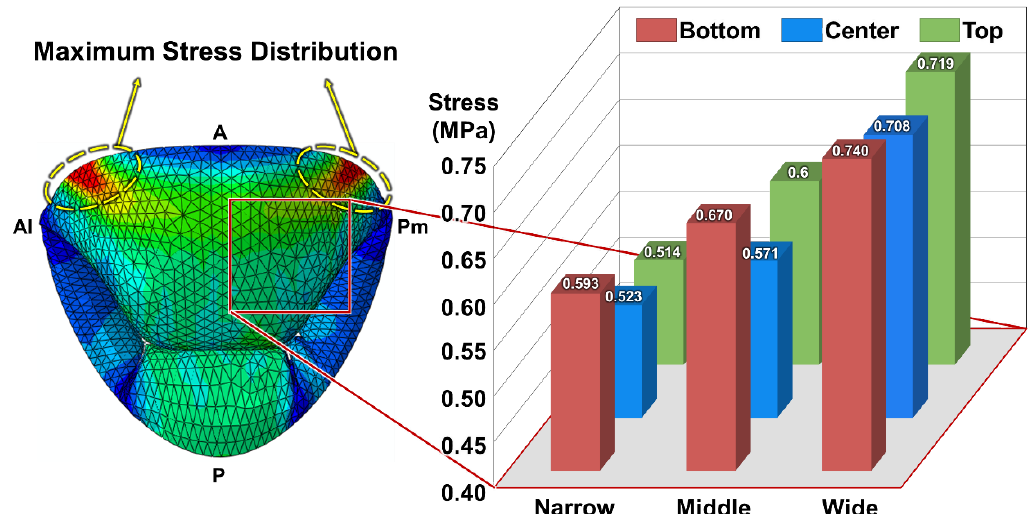
Figure 4. Stress distributions on the MV leaflets at peak systole with respect to alteration of the SC insertion location (atrial viewpoint). A — anterior; Al — anterolateral; P — posterior; Pm — posteromedial.